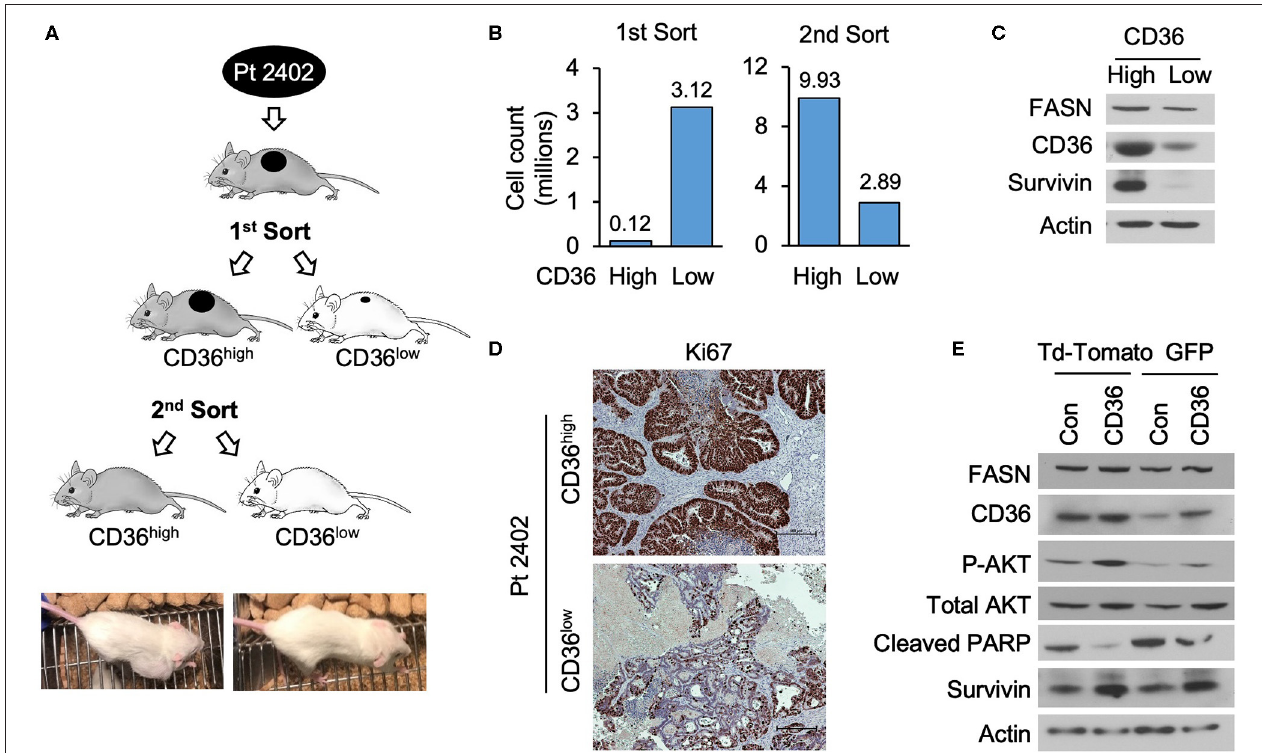
FIGURE 5 | High expression of CD36 is associated with an increase in pAkt and survivin in CRC. (A) Diagram of Pt 2402 propagation after flow cytometry sorting for CD36 high and CD36 low cells. (B) Numbers of CD36 high and CD36 low Pt 2402 cells for first and second flow cytometry sorts. (C) Protein expression levels of FASN, CD36, and survivin in CD36 high and CD36 low Pt 2402 primary cells from first flow cytometry sort. (D) IHC staining for Ki67 in Pt 2402 CD36 high and CD36 low tumors. (E) Protein expression levels of FASN, CD36, pAkt, cleaved PARP, and survivin in HCT116 CRC cells, control, and CD36